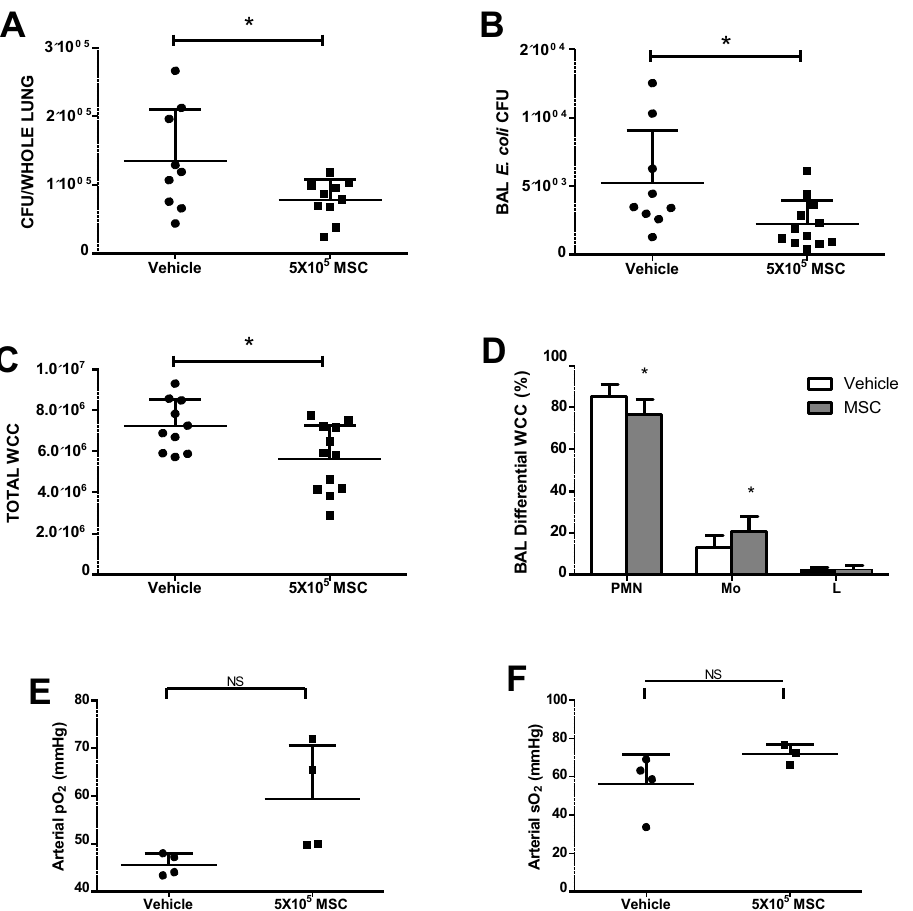
Figure 7. Administration of CFSE-labelled MSCs to murine models of E. coli pneumonia demonstrated that their therapeutic abilities were retained. Bacterial CFU were significantly reduced in BAL and lung tissue ( A , B ), total white cells counts and the fraction of inflammatory cells in the BAL were significantly reduced ( C , D ) and administration of MSCs resulted in a trend toward improved oxygenation ( E , F ).CFSE: Carboxyfluorescein succinimidyl ester; MSC: Mesenchymal Stem Cell; BAL: Bronchioalveolar lavage; CFU: Colony forming units. Columns represent mean + SD (n = 3–6),* = P < 0.05 versus Vehicle